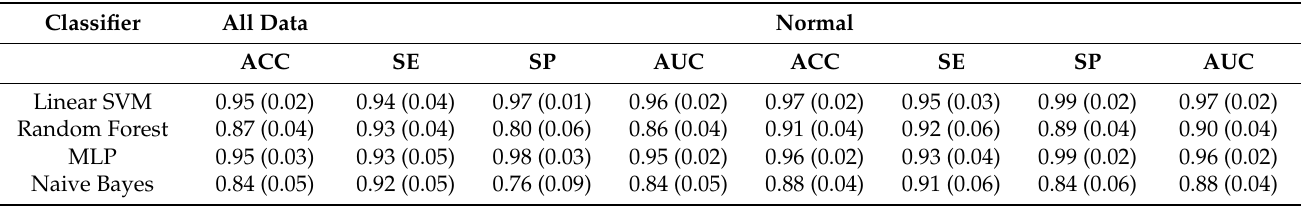
Table 2. Classification accuracies of digital signatures. ((std) indicates ± 2 standard deviation, ACC accuracy, SE sensitivity, SP specificity, AUC area under the curve, n = 1000